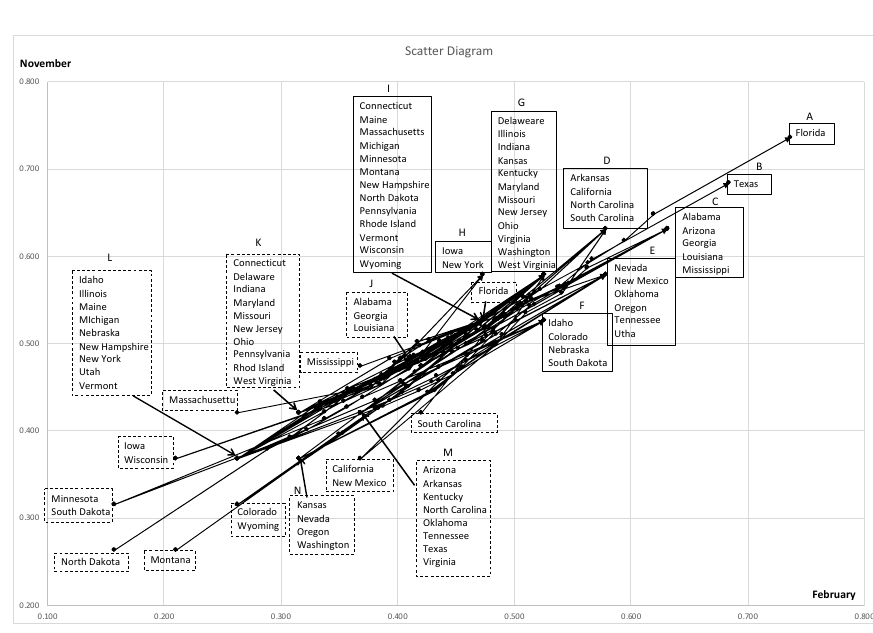
Figure 21. The scatter diagram of 48 distributions for February and November. Under the cut point 0.5, four major clusters, C1~C4, are obtained. Six sub-clusters found in Figure 20 are reproduced in the dendrogram using two features. Sub-cluster (2) obtained in Figure 20 was divided into two smaller sub-clusters (Connecticut, Pennsylvania, Rhode Island, and Massachusetts) and (Delaware, New Jersey, and Ohio). Each of them was merged into different major clusters C4 and C2, respectively. (Illinois, Washington, Kansas, New York, and Iowa) is newly generated cluster C3. Minnesota, Montana, North Dakota, and South Dakota have very small minimum quantile vectors in Figures 19 and 21. They organized a single cluster in Figure 20, while they organized two isolated clusters (Montana, North Dakota) and (Minnesota, South Dakota) with the compactness exceeding 0.5 in Figure 22. We should note that the values of compactness of sub-clusters in Figure 22 are less than those values of the same sub-clusters in Figure 20. Figure 23 is the scatter diagram of eleven distributions including four major clusters and seven outliers. Each bin-rectangle for a cluster is overlapped with bin-rectangles of other clusters and with remaining states. However, the distinctions between clusters and other states are clear from the maximum quantile vectors and/or the minimum quantile vectors. In other words, we can explain the relationships between eleven distributions by using their mutual positions of the maximum and/or the minimum quantile vectors.